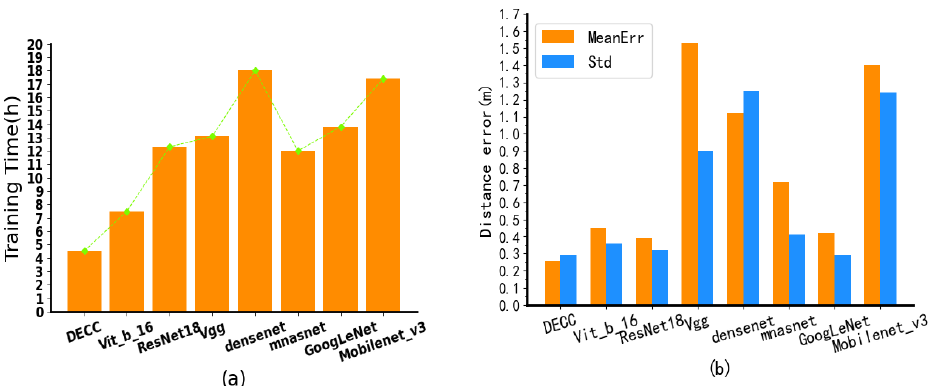
Figure 13. Comparisons of DECC with various classic DL models, in terms of ( a ) time overheads and ( b ) distance